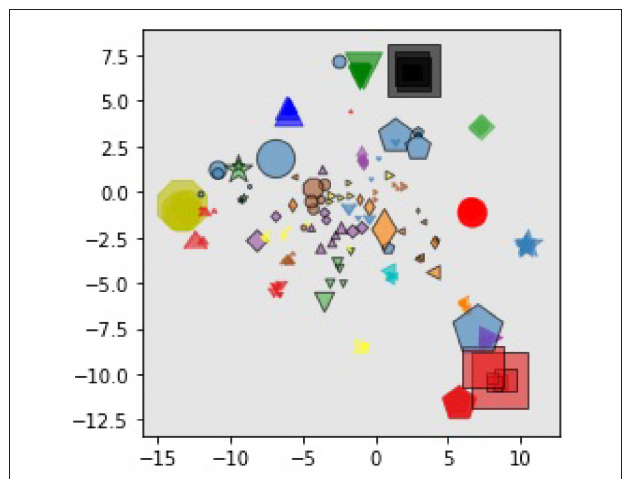
FIGURE 2 | Visualization of task embedding for randomly selected demonstrations, which is reduced to two-dimensional space with t-SNE. Points with the same marker denote demonstrations from the same task and markers with black round means demonstrations in meta-test tasks. The size of each marker is proportional to the variance of the task